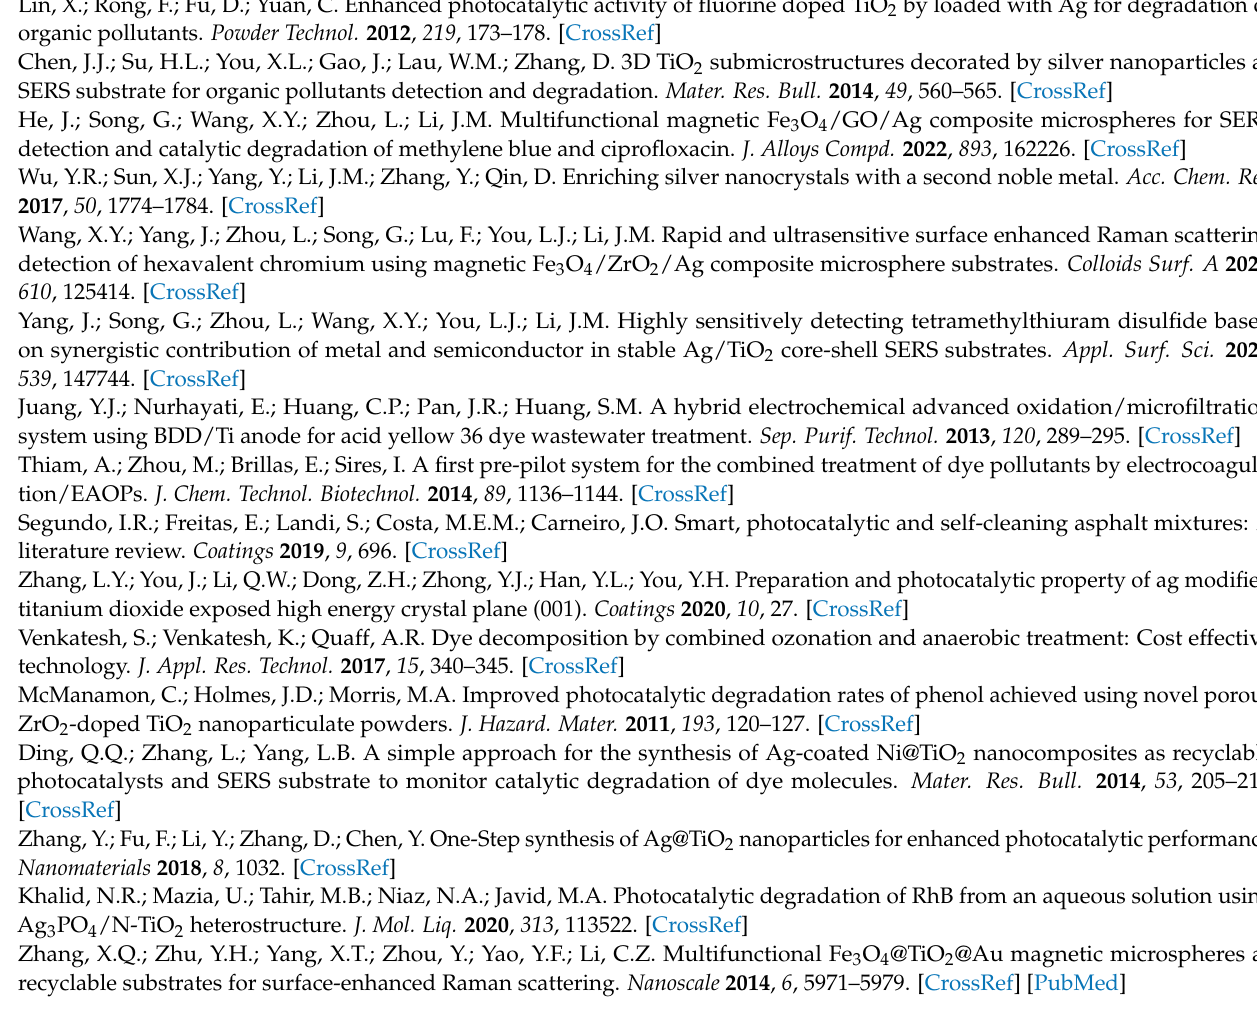
Figure S2. FESEM image of mTiO 2 nanospheres (the size is about 90